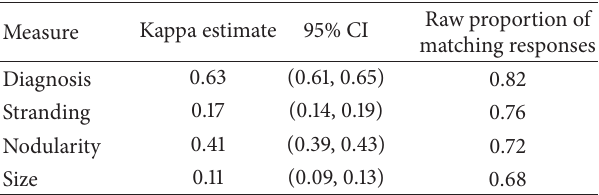
Table 1: The interrater reliability for diagnosis and each of the categorical variables of stranding, nodularity, and size.